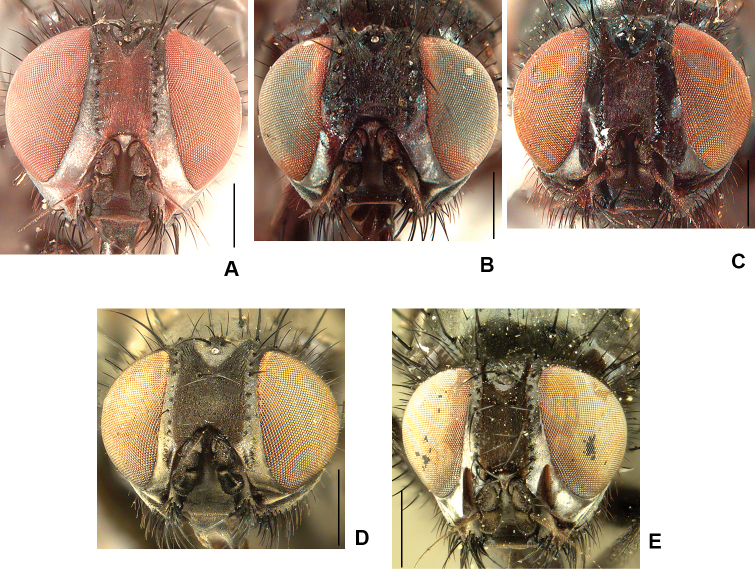
Female frons AD.
similisBD.
latifronsCD.
profrontalisDD.
pontiED.
hucketti. Scale bars: 0.5 mm.